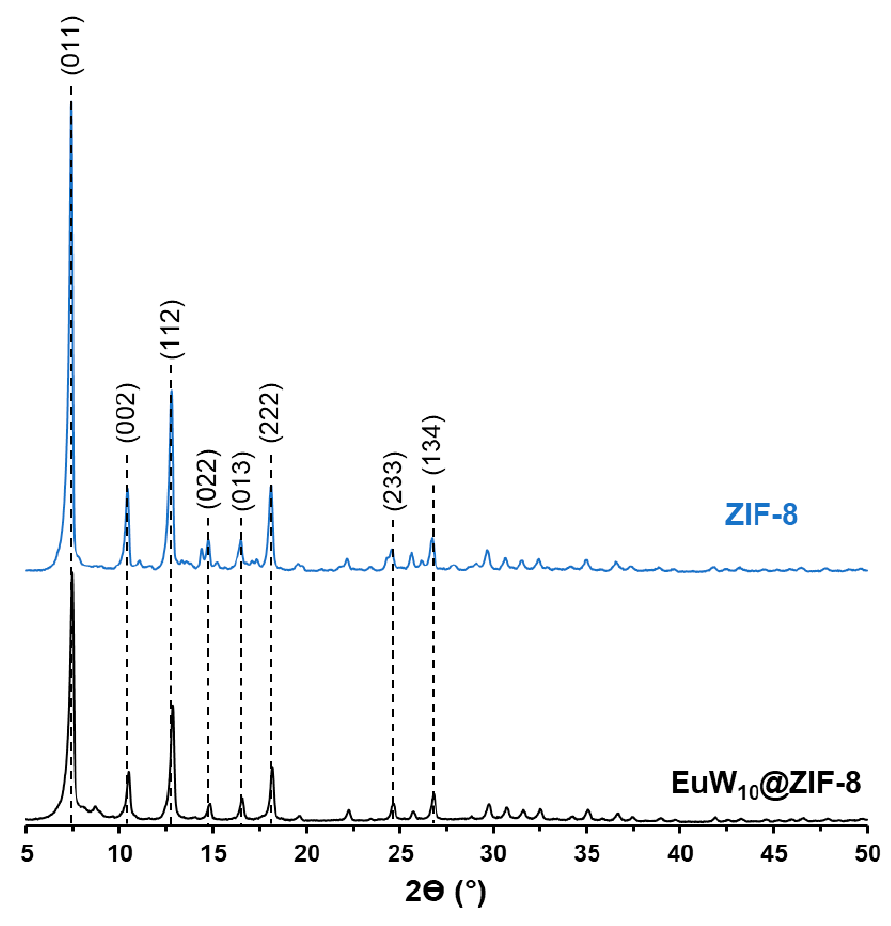
structure remained intact in the final composite. The EDS spectrum (Figure S1B) shows,